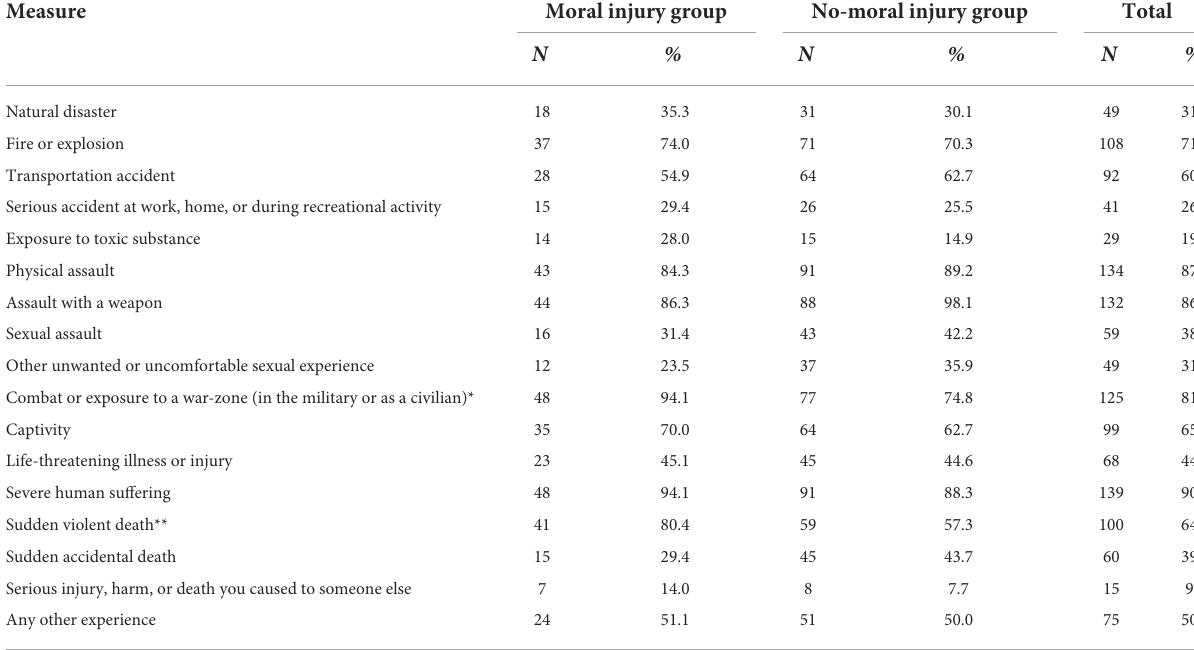
TABLE 2 Number and percentage of the traumatic events reported by participants in each group. Measure Moral injury